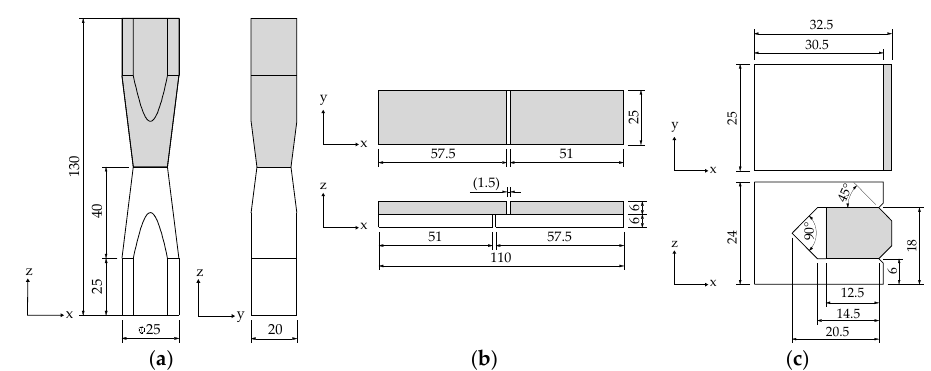
Figure 4. Geometry and dimensions of the developed test specimens, dimensions in millimeters for: ( a ) tensile, ( b ) lap-shear, and ( c ) compression-shear (scale-factor: 2).